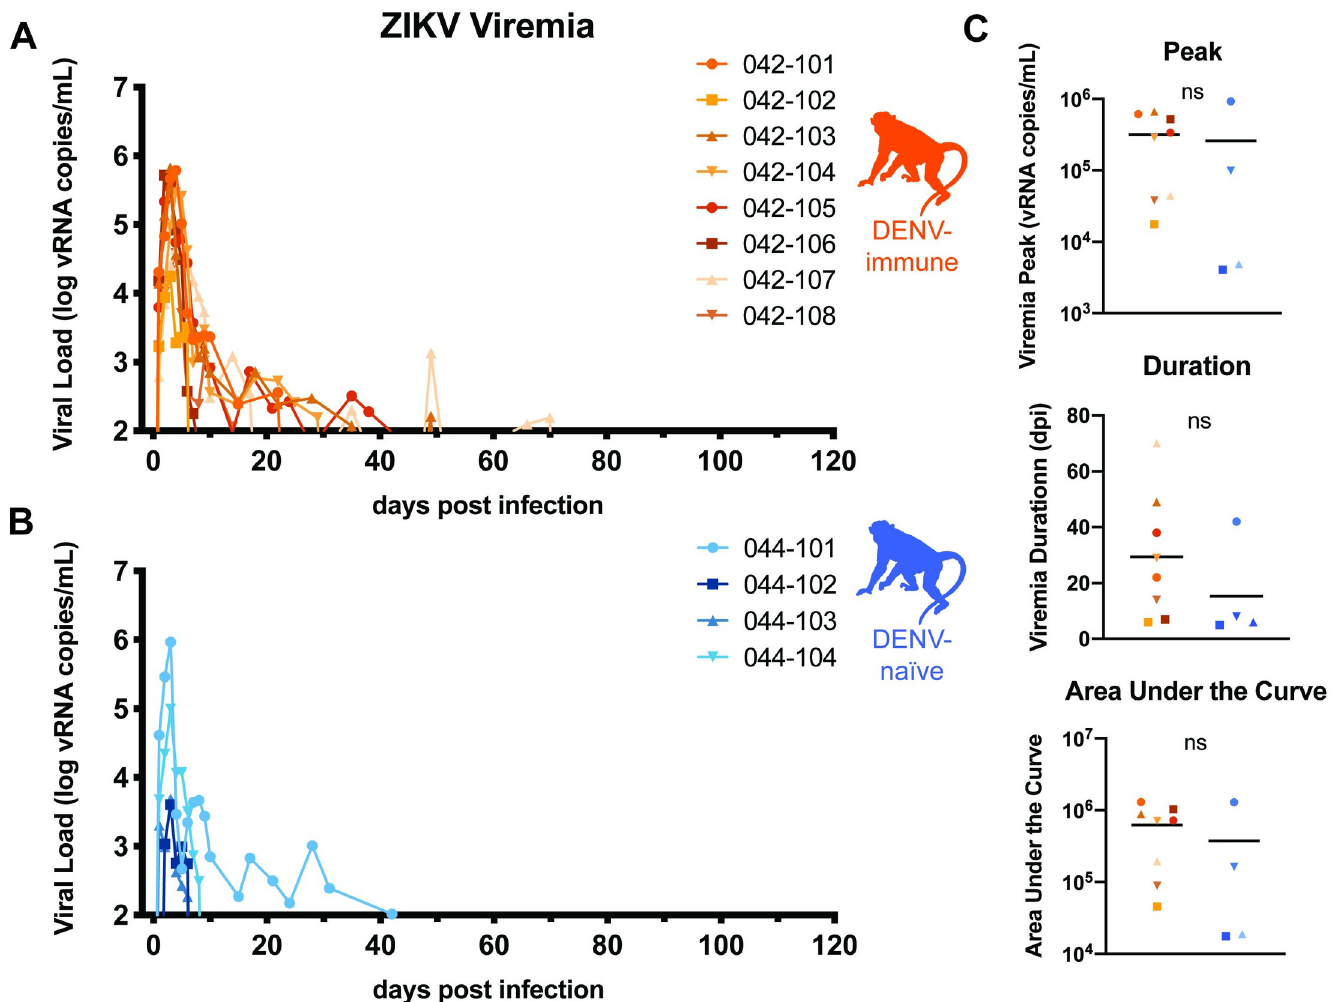
Fig 3. ZIKV replication kinetics. Eight DENV-immune (A, orange) and four DENV-na ï ve (B, blue) macaques were challenged with 10 4 PFU of ZIKV-PRVABC59 at gestation day 45, which is late in the first trimester. Viral loads were assessed from plasma samples with ZIKV-specific QRT-PCR. All values above the limit of quantification (100 copies vRNA/mL plasma) are shown above. C. Graphs of the values for the peak, duration, and area under the curve of viremia for both DENV- immune and DENV-na ï ve macaques. An unpaired t-test was used for statistical comparison; ns = not significant (p > 0.05). Only values above the limit of quantification were used in statistical